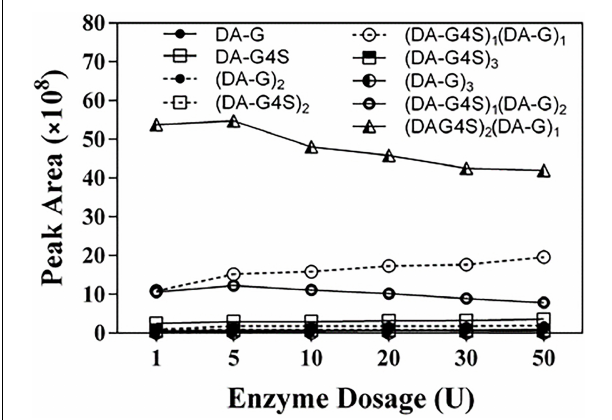
FIGURE 9 | LC-HRMS analysis of products prepared by incubating 100 mg substrate with different enzyme dosages (1–50 U) of Cgbk16A_Wf for 24 h. Respective plots for disaccharides, tetrasaccharides, and hexasaccharide are found in Supplementary Figure 4